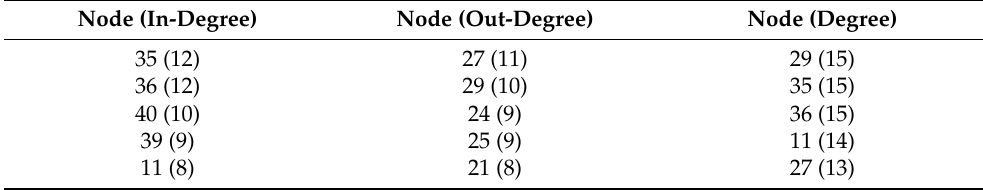
Table 2. Nodes with larger in-degrees, out-degrees, and degrees. Node